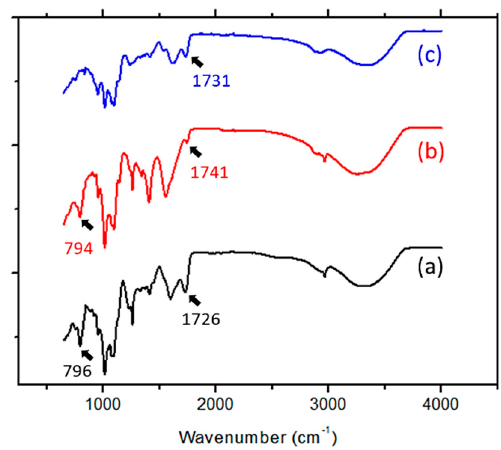
Figure 3. FTIR analysis of hydrogels prepared at ( a ) pH 4, ( b ) pH 5.6 and ( c ) pH 6.5.